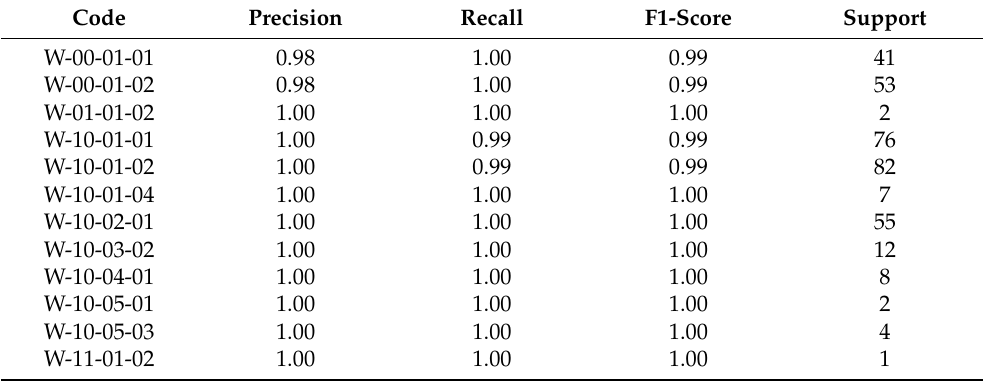
Table 6. RF Classification